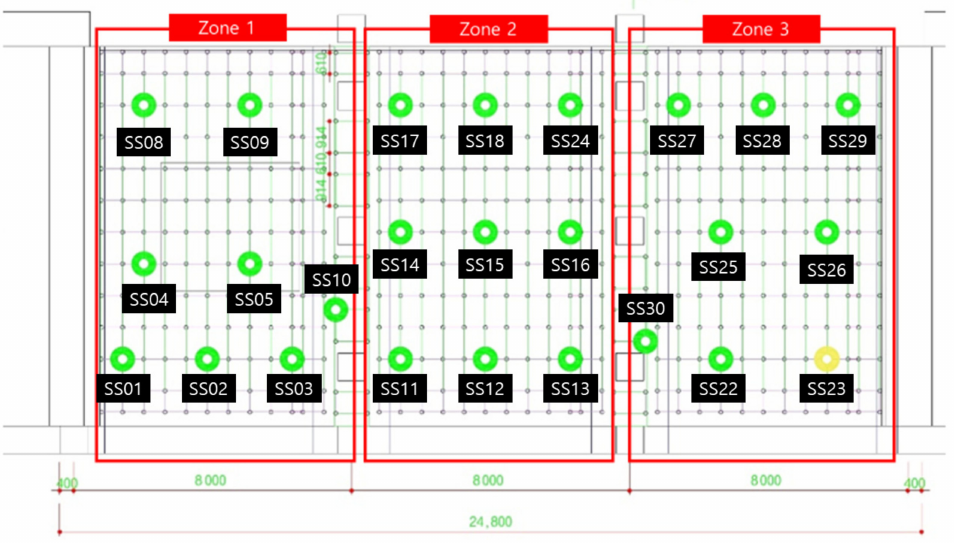
Figure 24. Load-monitoring screen (11:30).